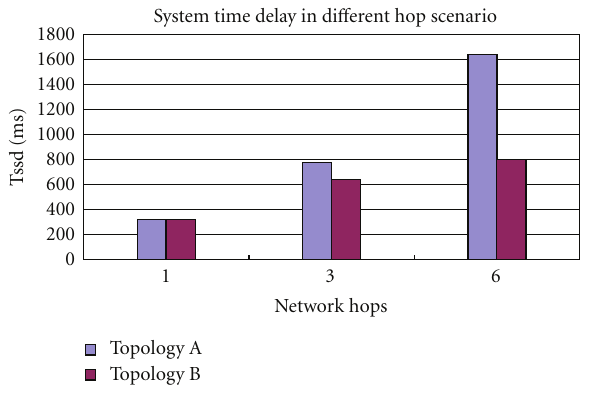
Figure 17: Relationship between network hops and system sharing delay in deferent topology. Table 2: Comparison between S-DMDS with NST-AODV.